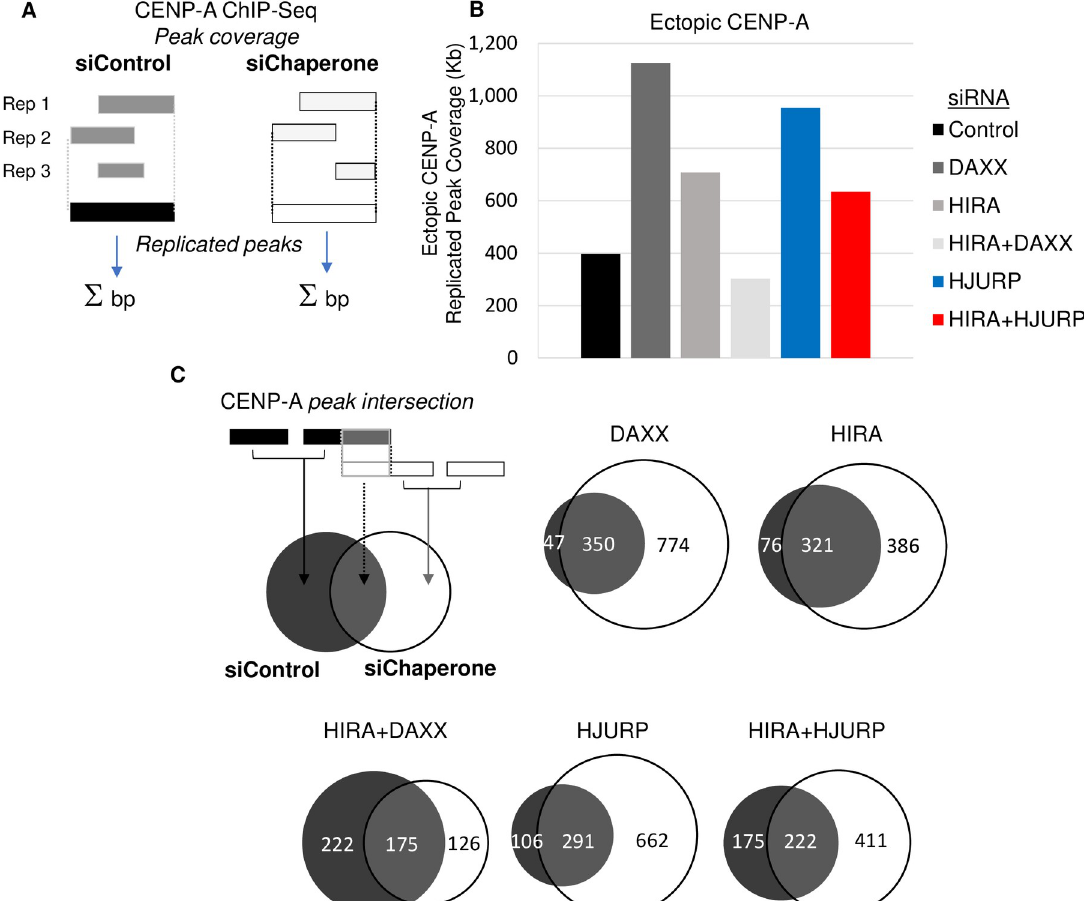
Fig 1. CENP-A Mislocalization requires the H3.3 chaperones HIRA and DAXX. A. Schematic of the definition of replicated peak sets and the calculation of ectopic CENP-A peak coverage. B. Bar chart showing the peak coverage, in kilobases, of replicated ectopic CENP-A peaks from 3 replicate ChIP-seq experiments after 72-hour knockdown of the indicated protein. C. Schematic of the intersection of peaks from control and chaperone knockdown samples. Proportional Venn diagrams showing the intersection between chaperone knockdown and control in kilobases of peak coverage. In each case, peak coverage that is newly acquired in the chaperone knockdown is in white.